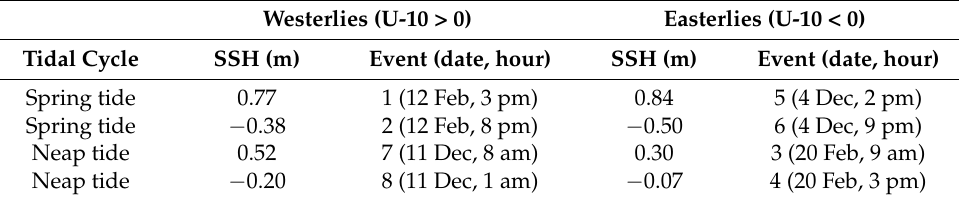
Table 2. Description of eight events categorized according to different met-ocean conditions.